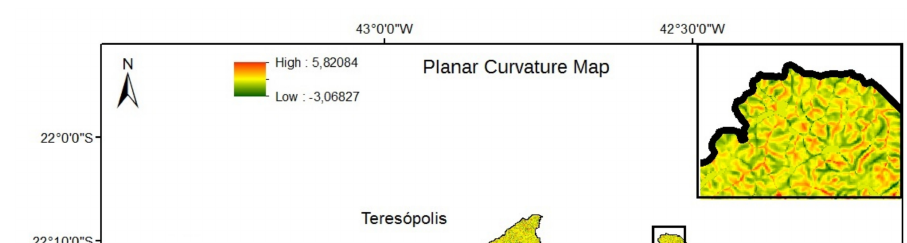
Figure A6. Profile Curvature Map.